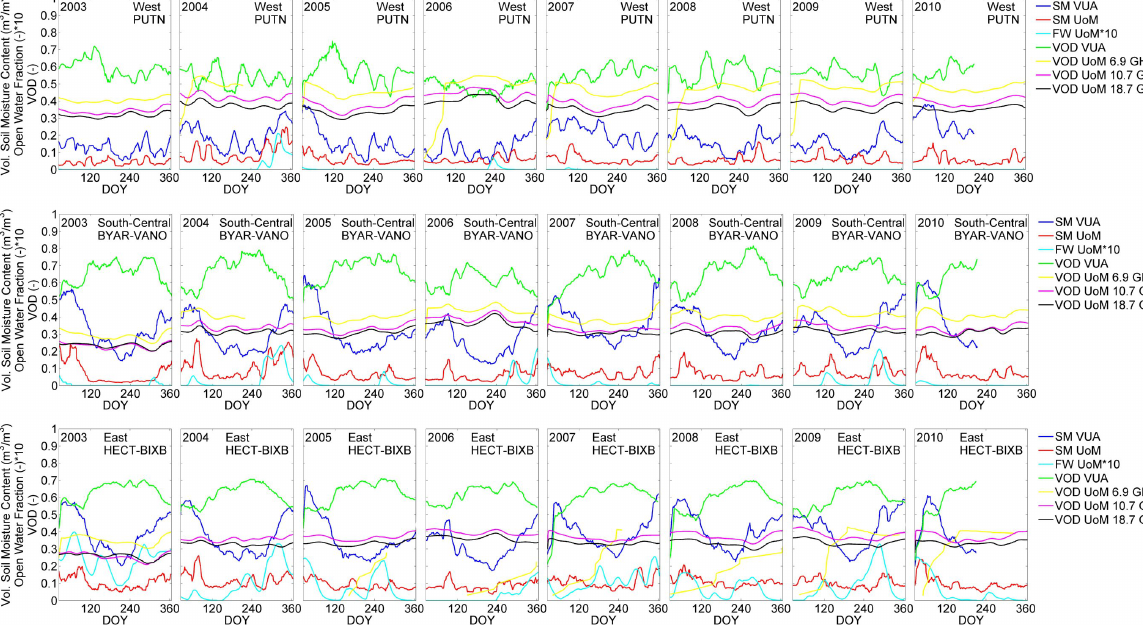
Fig. 7. Time series from 2003 to (mid-) 2010 of the current VUA rel and UoM soil moisture and VOD products, together with the smoothed UoM OWF (30-day moving median filter), for the Western (top), South-Central (middle) and Eastern (lower) Oklahoma